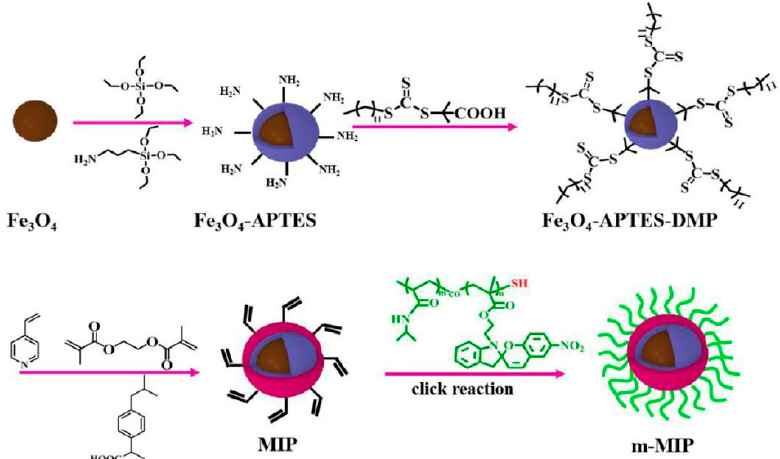
Figure 15. Schematic synthesis of core-shell MIP nanospheres with multiple responsive properties. Reprinted with permission from [81]. Copyright (2022) American Chemical Society.